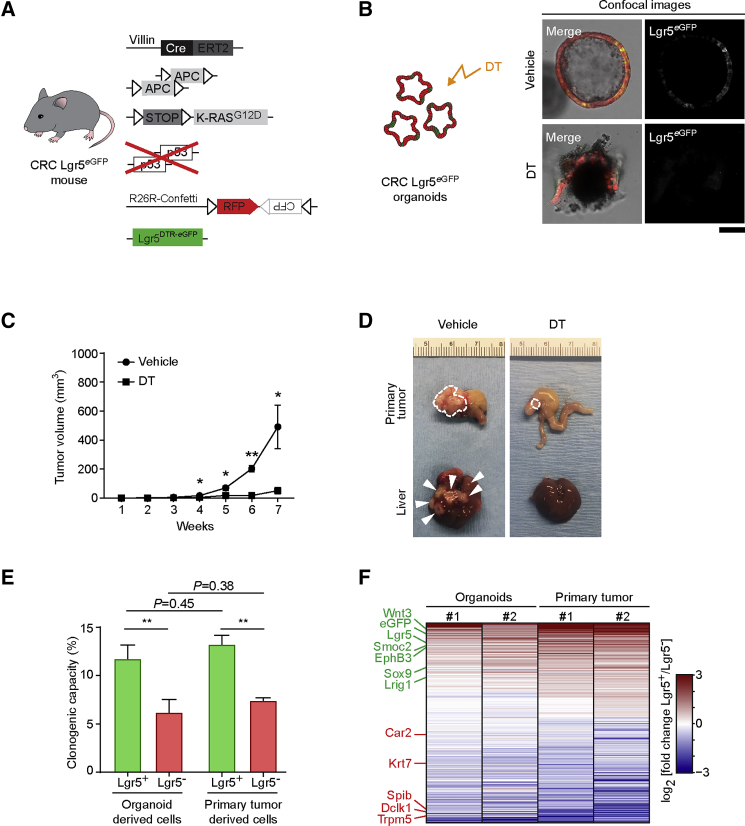
Generation of a Colorectal Cancer Mouse Model to Visualize Lgr5+ CSCs(A) Schematic overview of the inducible fluorescent CRC mouse model generated to visualize Lgr5+ CSCs.(B) Diphtheria toxin (DT) treatment of CRC Lgr5eGFP organoids. Representative confocal images of the effect of vehicle or DT on organoid growth. Scale bar, 100 μm.(C) Prolonged diphtheria toxin (DT) treatment of mice orthotopically transplanted with CRC Lgr5eGFP organoids. Average tumor growth upon vehicle or DT treatment (n = 5). ∗p < 0.05 and ∗∗p < 0.001. Data are presented as mean ± SEM; p values were calculated using the Mann-Whitney U test.(D) Representative examples of primary tumors and livers of mice subjected to either vehicle or DT treatment for 8 weeks. Dashed lines highlight primary tumor edges, arrowheads indicate macroscopic metastatic lesions.(E) Clonogenicity assay of sorted Lgr5+ CSCs and Lgr5− cancer cells derived from CRC organoid cultures and orthotopic colorectal primary tumors. Data were collected 6 days after plating (n = 3 independent experiments). Values are presented as mean ± SEM; p values calculated using the unpaired t test with Welch’s correction.(F) Heatmap of differentially expressed transcripts in cancer cells derived from two independent biological replicates of organoids and orthotopic primary tumors. Genes marked in green are known to be upregulated in intestinal stem cells; genes marked in red are known intestinal differentiated cell markers.